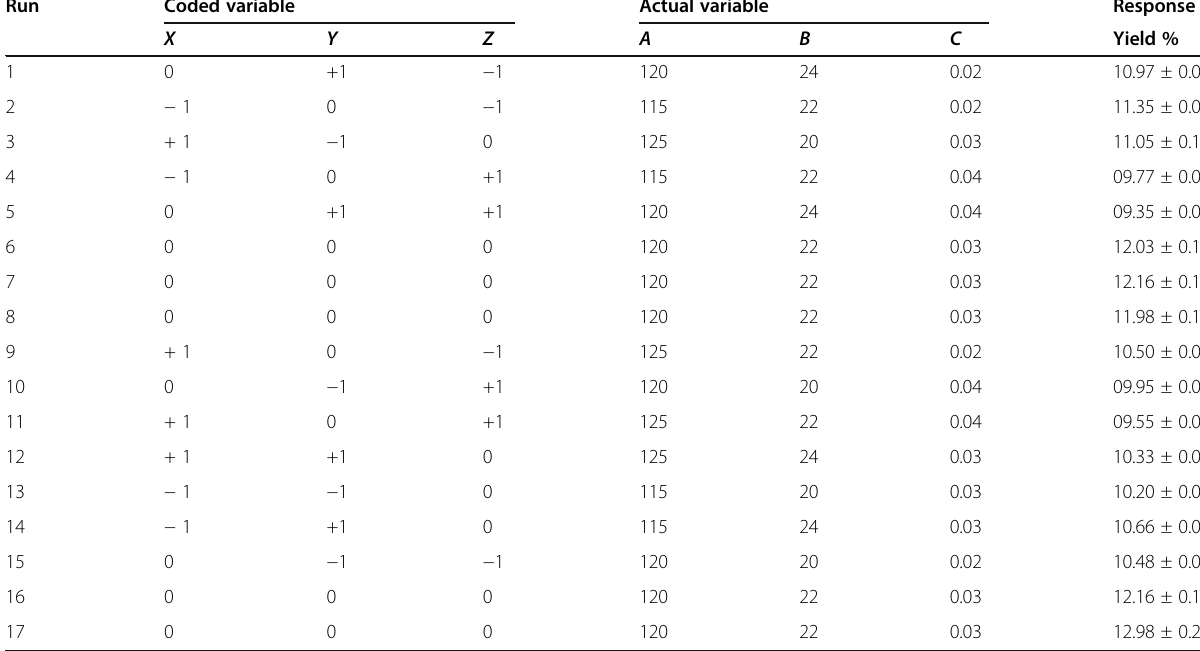
Table 2 Test design and results of response surface analysis (each test was performed in triplicate)